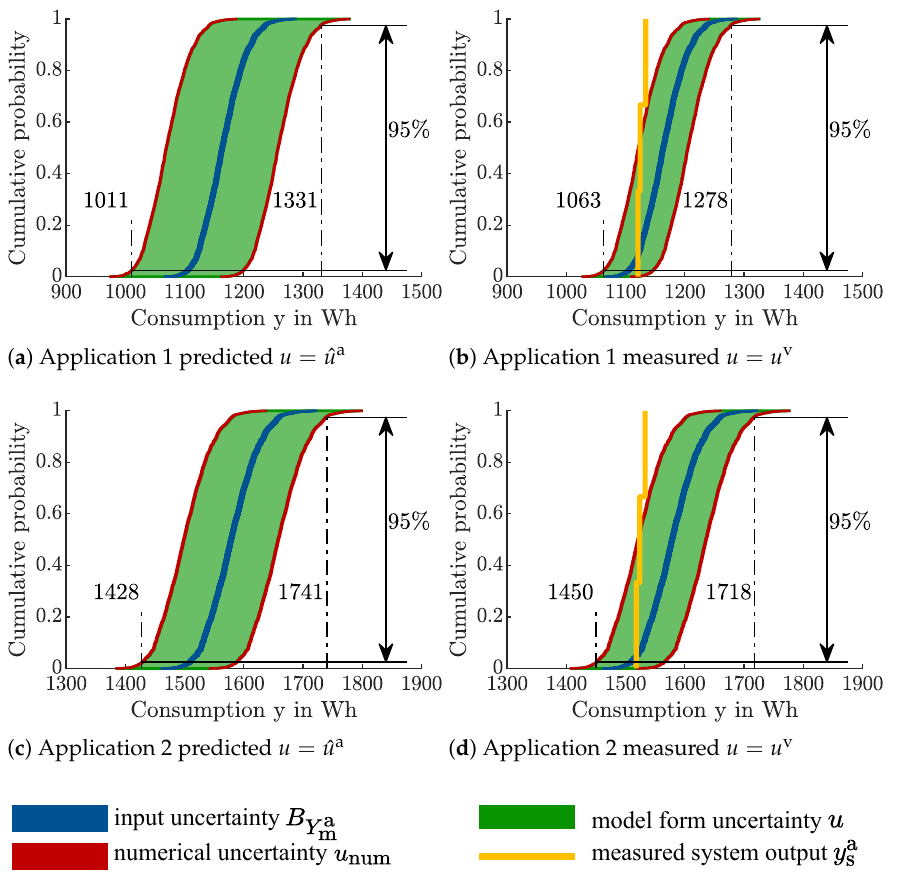
Figure 10. Validation of the uncertainty prediction method showing the 95% confidence interval of the total output uncertainty of the two test application parameter configurations. The left side shows the predicted total uncertainty B ˆ using the predictions of G pred to predict the model uncertainty Y a ˆ u a . The right side shows the measured total uncertainty B Y a using additional measurements and the AVM to calculate the real model uncertainty u v .